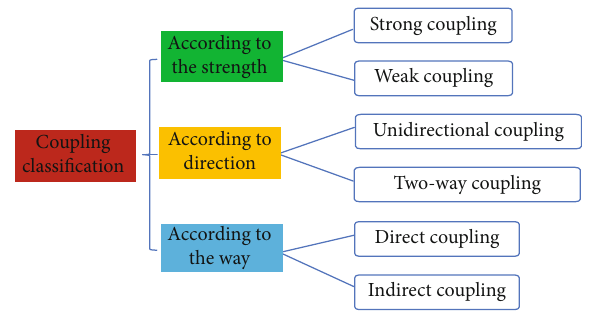
Figure 1: Coupling classi fi